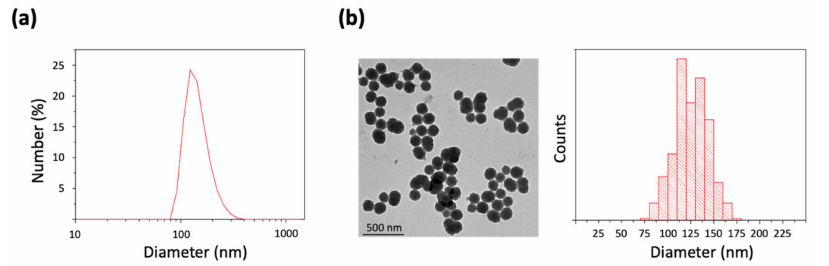
Figure 1. ( a ) DLS number distribution of the PDA NPs synthesized, suspended in Trizma base solution (pH 10.0); ( b ) TEM image and size–range histogram of the PDA NPs